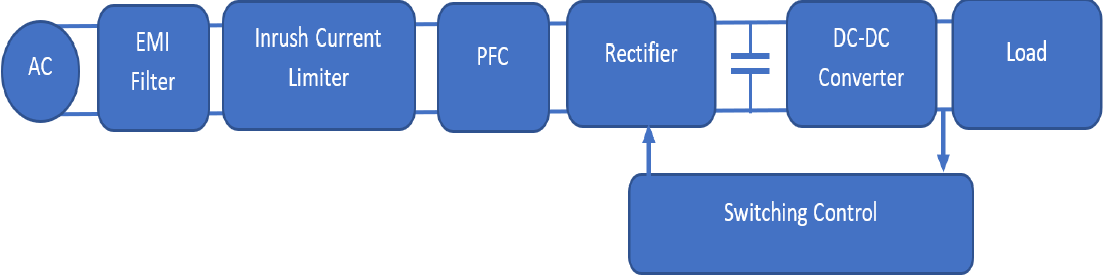
Figure 1. Block diagram of a typical switch-mode power